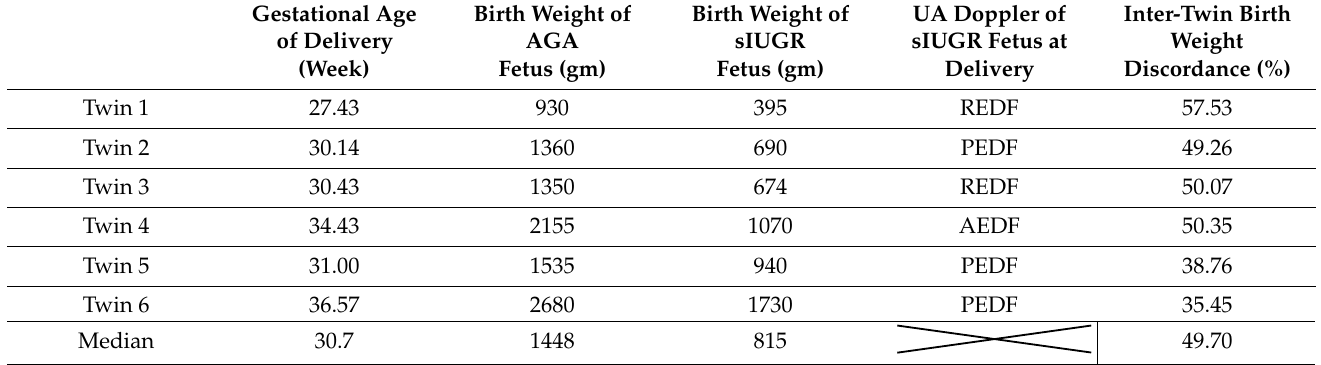
Table 1. Characteristics of the six pairs of monochorionic twin pregnancies with selective intrauterine growth restriction (sIUGR).